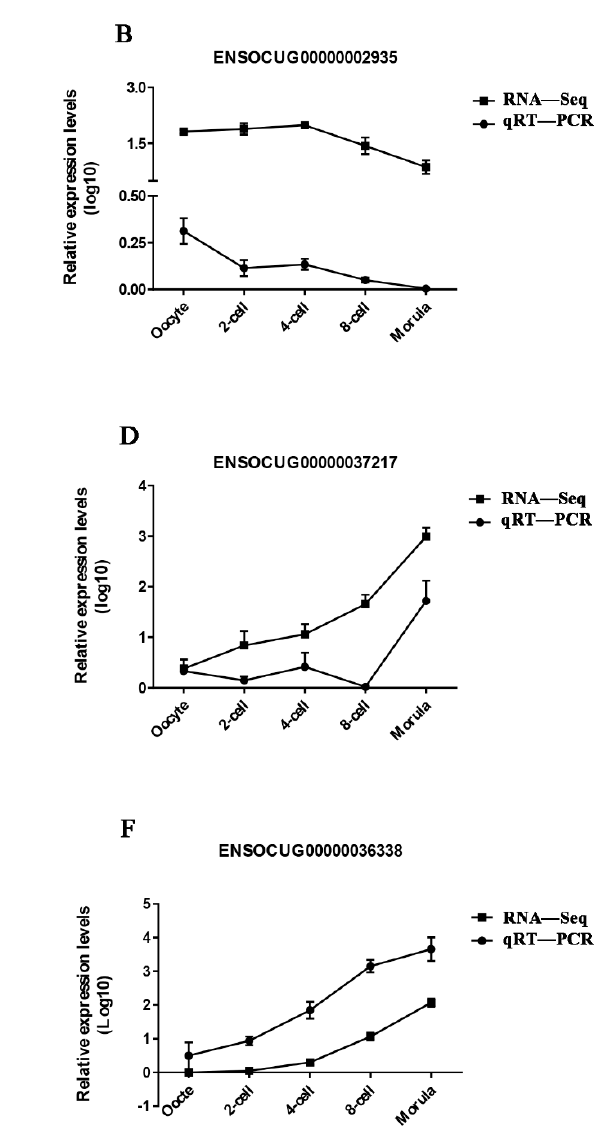
Figure 4. Validation of six DE lncRNAs including ENSOCUG0000036653 ( A ), ENSOCUG0000002935 ( B ), ENSOCUG0000032001 ( C ), ENSOCUG0000037217 ( D ), ENSOCUG0000034943 ( E ) and ENSOCUG0000036338 ( F ) by RT-qPCR.